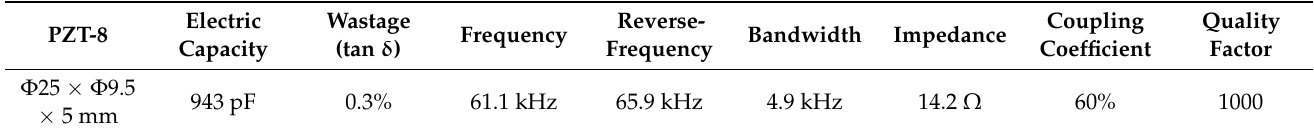
Table 1. Piezoelectric properties of PZT-8.